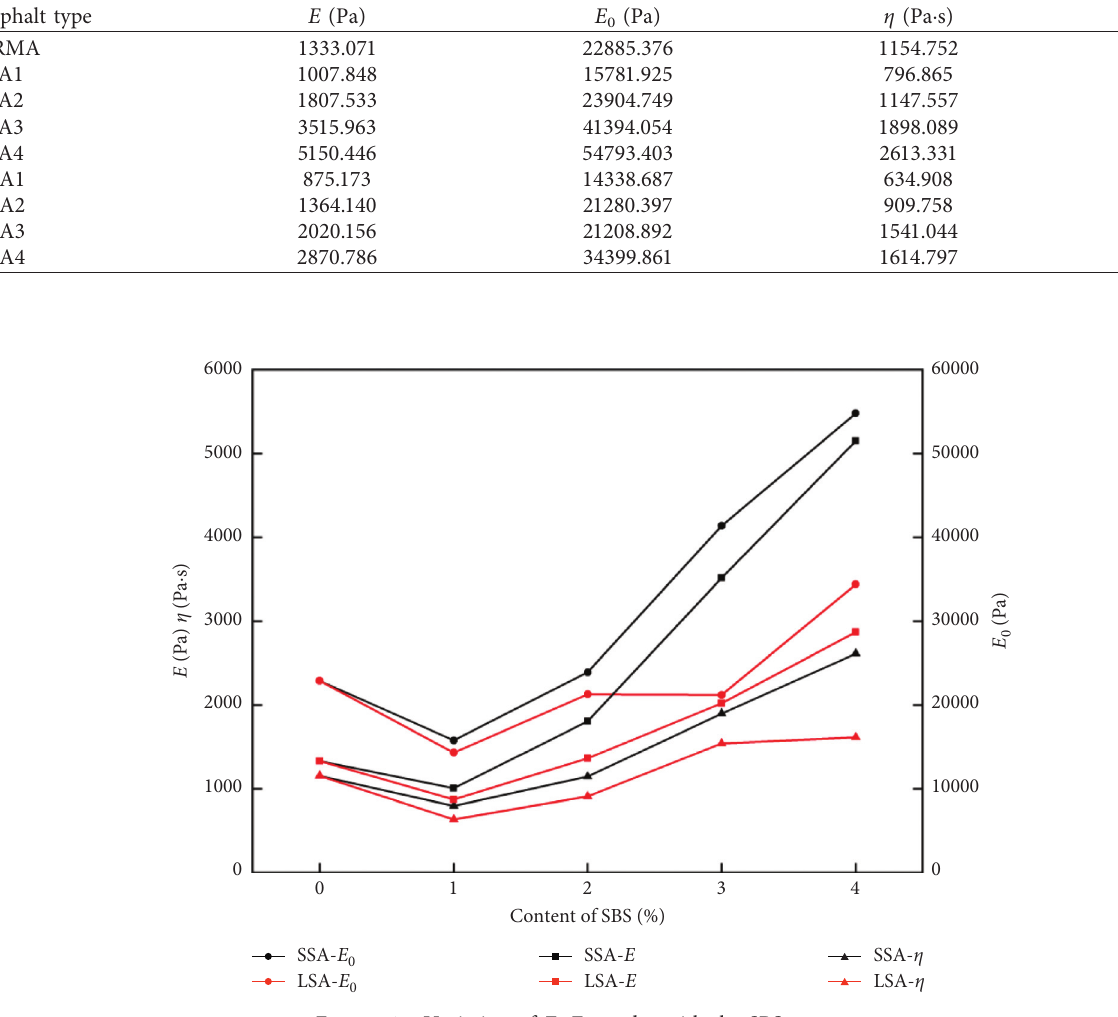
, and η with the SBS 0